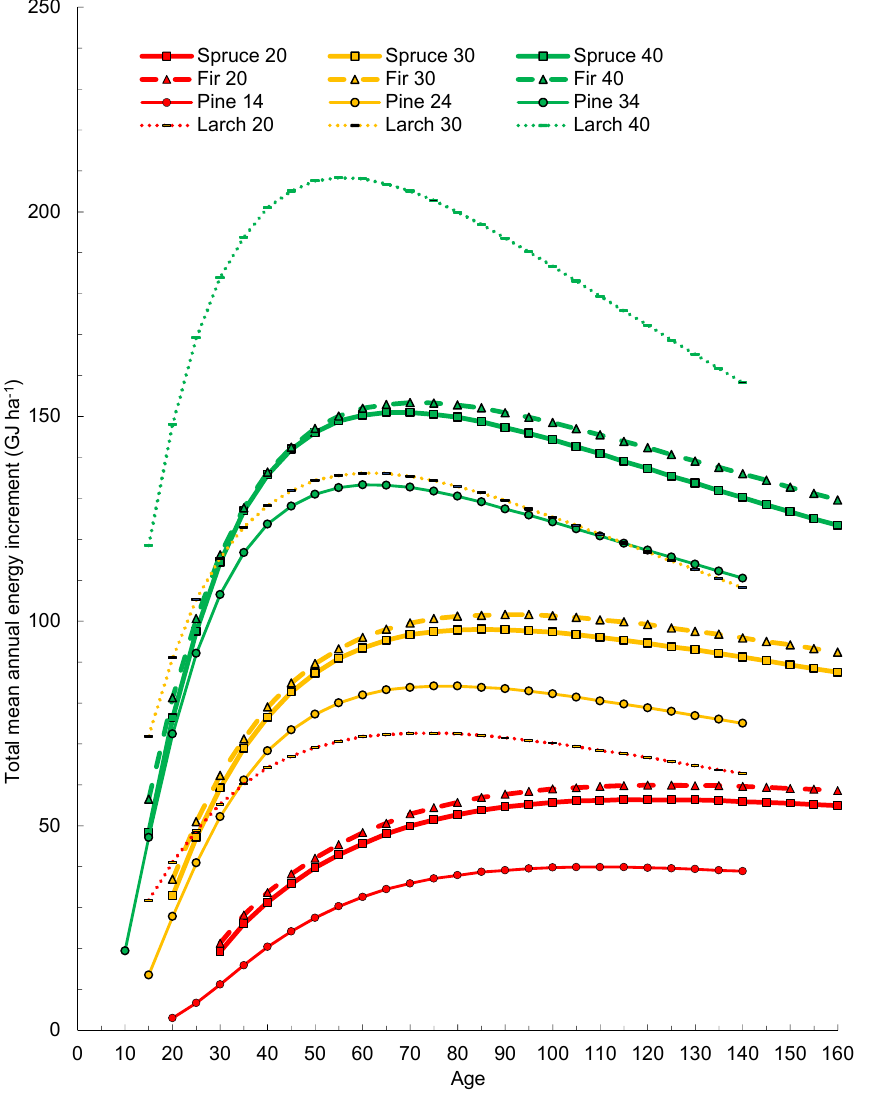
Figure 3. Development of energy reserves in the total mean increments of coniferous stands depending on their age and site index (20, 30, 40 for spruce, fir and larch; 14, 24, 34 for pine). Stands with the lowest site index usually grow up to the age of 115–125 years; only larch stands grow up to the age of 80 years. In stands with higher site indices, they in- crease to the age of 90 ‒ 95 years (spruce and fir stands) or 60 ‒ 80 years (pine and larch stands).